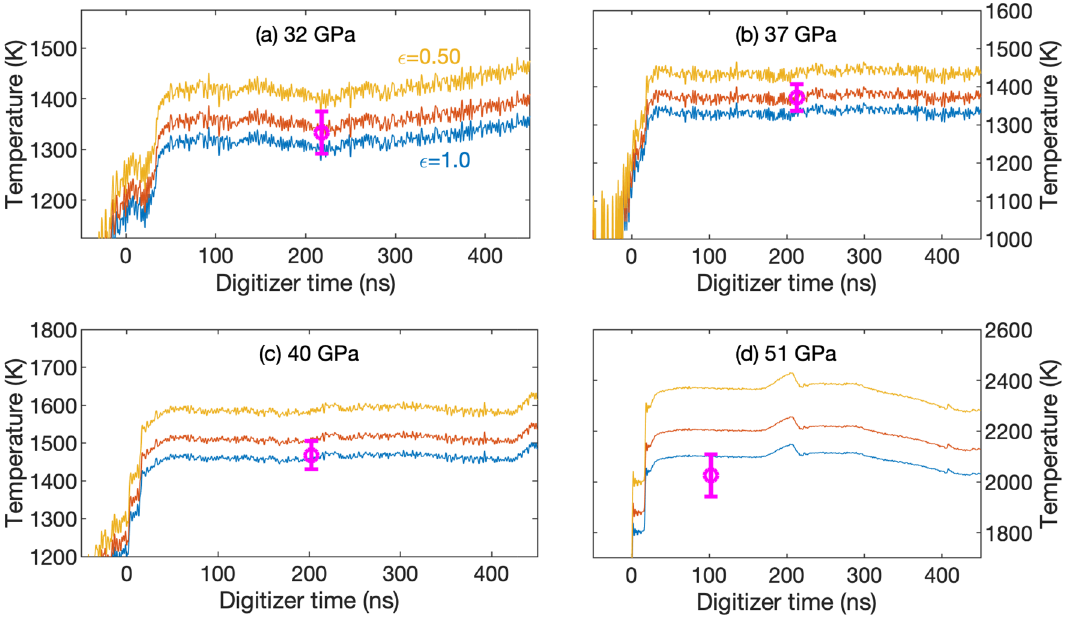
Figure 7. Temperatures calculated from 1125 nm pyrometry signals at emissivities of 1.0, 0.75, and 0.50. Circle symbol and error bars indicate values from Table 2. This is an averaged value over four wavelength bands. The temperature in (d) is lower because the longer wavelength channels give temperatures below the 1125 nm value.